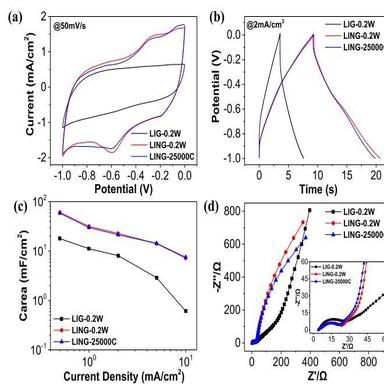
(a) CV curves of the LING-0.2W electrode at the scan rate from 5 to 200 mV/s (b) GCD curves of the LING-0.2W electrode at various current densities ranging from 1 to 10 mA/ cm2 . (c) Cycle stability of LING-0.2W electrode measured at current densities of 10 mA/cm2 ; (inset) the corresponding GCD curves of the last 20 cycles of the LING-0.2W electrode. (dee) Comparison Ragone plots of LIG-0.2W, LING-0.2W electrodes and some reported energy storage devices. Data were reproduced from Refs.